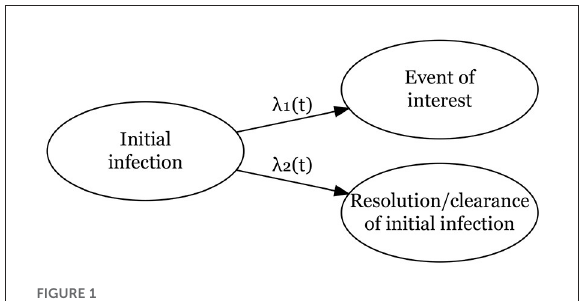
FIGURE1 Competing risks model for two events, a main event of interest from an initial infection and clearance/resolution of the initial infection without the main event of